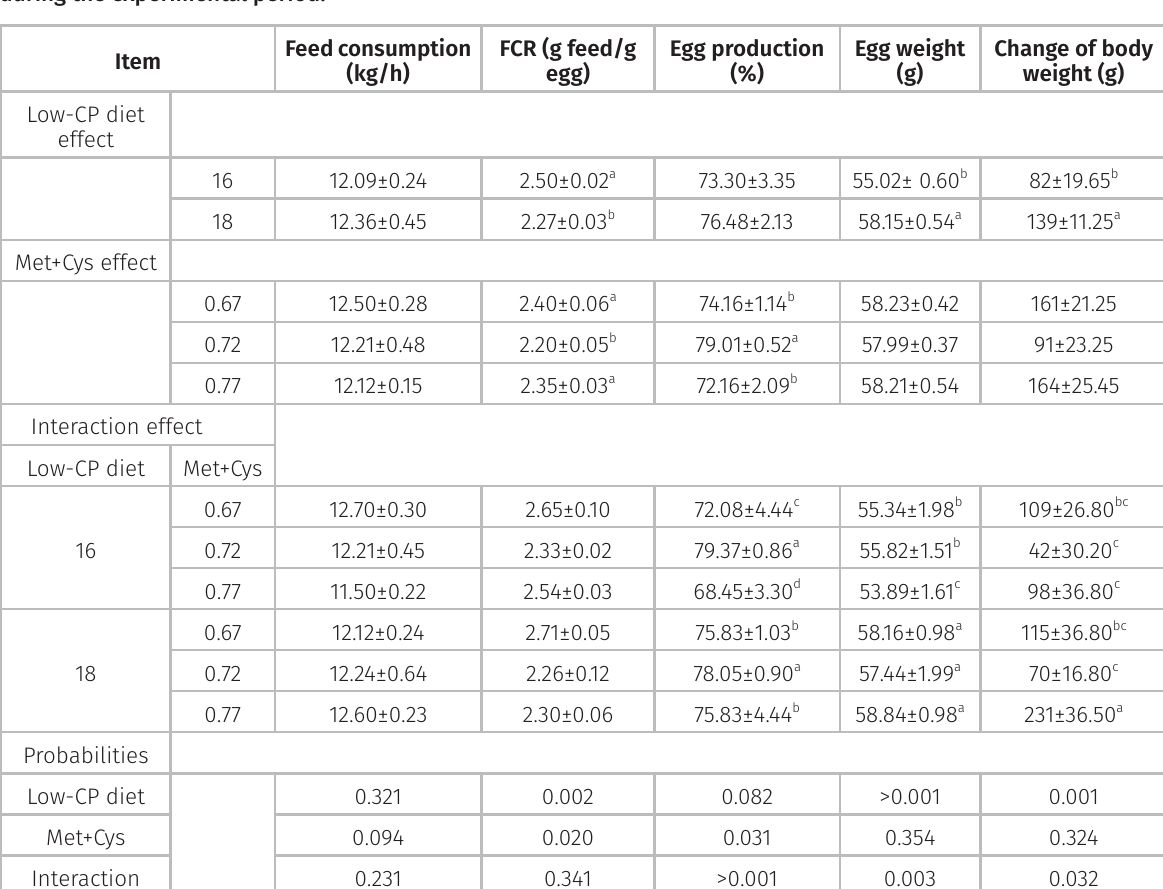
Table II. Effect of low-protein diet with different levels of Met+Cys on productive performance of laying hens during the experimental